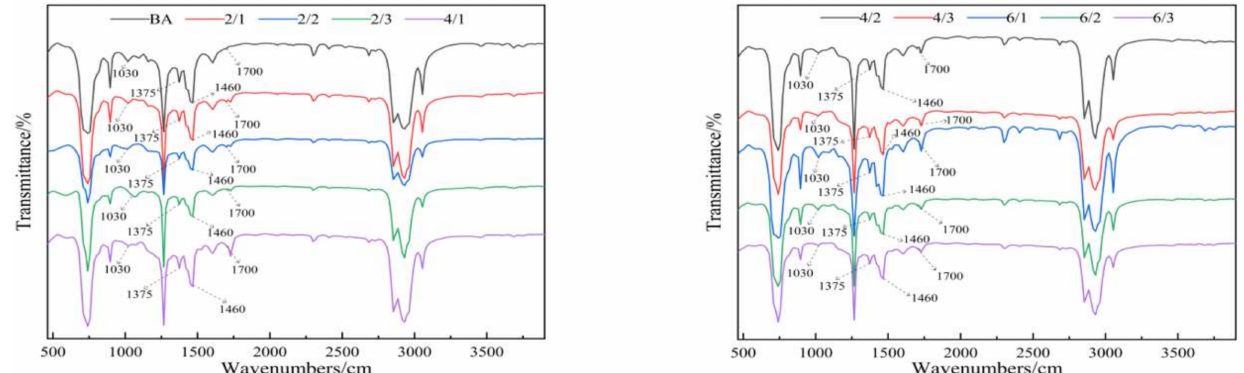
Figure 10. An infrared spectrum of asphalt before aging.